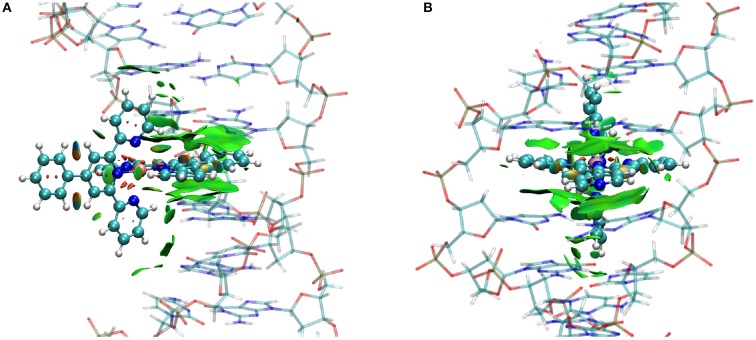
NCI plot for a representative conformation of FeC-2 (A) and FeC-3 (B) intercalated in the poly(dG)-poly(dC) double strand. The iron complex is represented in ball and stick representation while the DNA is in shaded licorice. Surfaces represent the non-covalent (π-stacking) interaction.